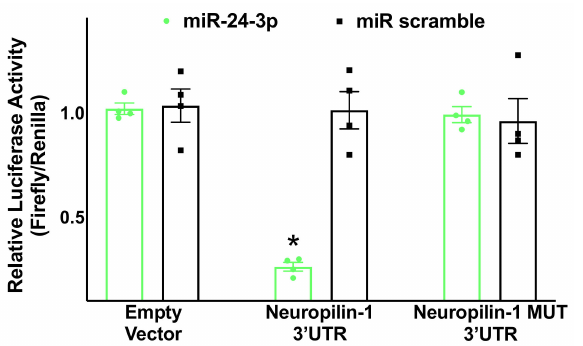
Figure 2. Validation of Neuropilin-1 targeting by miR-24. Luciferase activity was measured in hBMECs 48 h after transfection, using the vector without Neuropilin-1 3 (cid:48) -UTR (empty vector), the vector containing the wild-type Neuropilin-1 3 (cid:48) -UTR, and the vector containing a mutated Neuropilin- 1 3 (cid:48) -UTR (Neuropilin-1 MUT); a non-targeting miRNA (miR scramble) has been employed as further control. Means ± S.E.M; * p < 0.05.